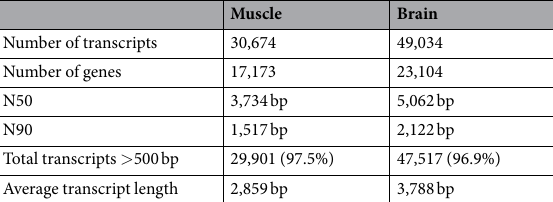
Table 1. Muscle and brain transcriptome